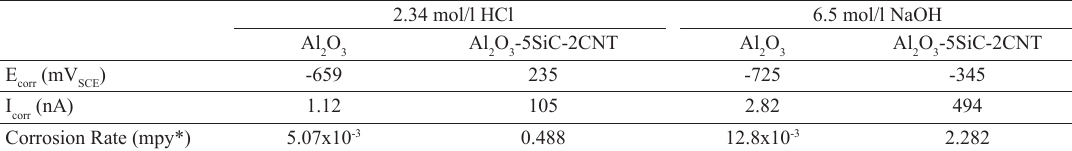
Table 1. Summary of potentiodynamic polarization data for spark plasma sintered Al in HCl and NaOH